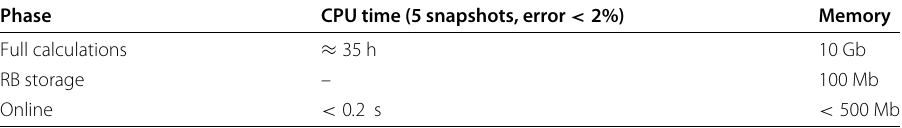
Table6 CPU time and memory (yield stress computational vademecum ) Phase CPU time (5 snapshots, error < 2%) Memory Full calculations ≈ 35 h RB storage